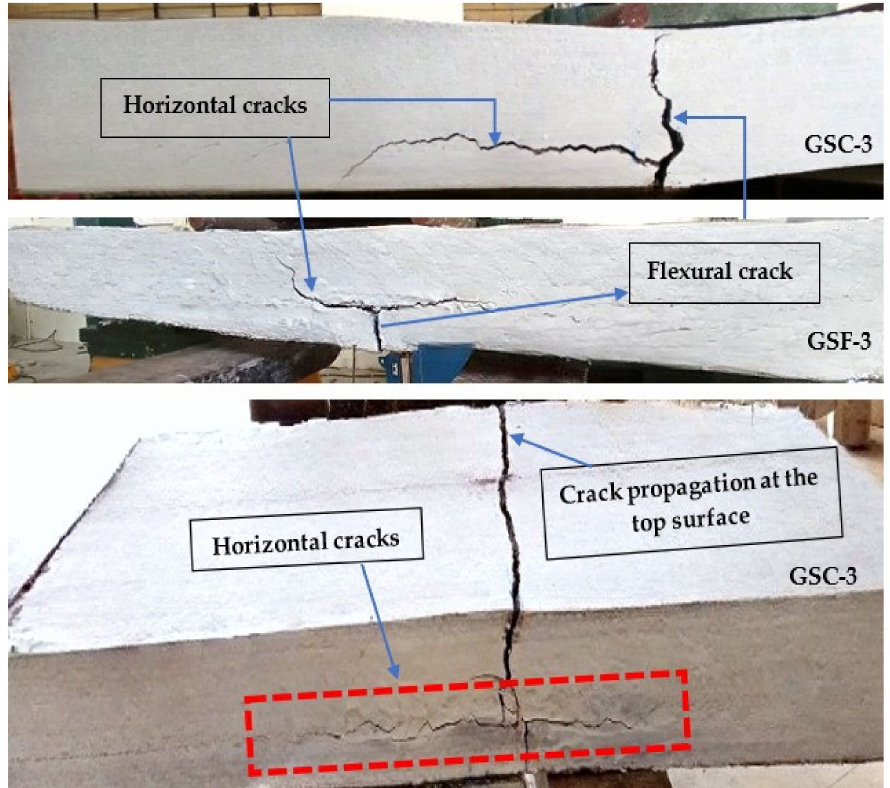
Figure 6. Crack propagation and failure mode of Mode-III slab